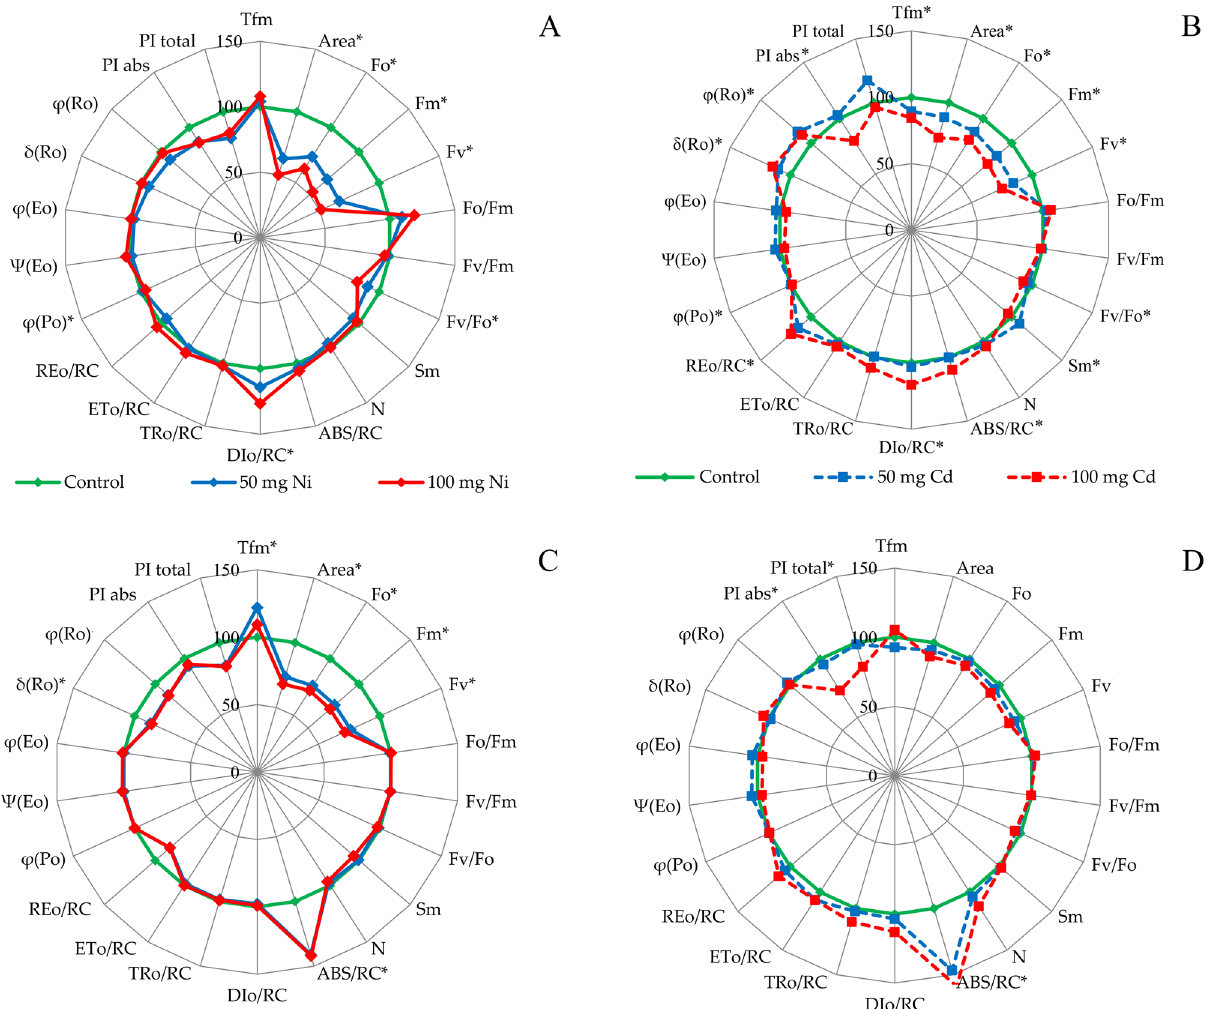
Figure 3. JIP-test parameters (relative units, normalized to the values from control conditions) as radar plots of two perennial ryegrass turf cultivars. ( A ) ‘Niga’ treated by Ni; ( B ) ‘Niga’ treated by Cd; ( C ) ‘Nira’ treated by Ni; ( D ): ‘Nira’ treated by Cd. The concentration of Ni and Cd were: 0; 50 and 100 mg × 100 g −1 of substrate. Means marked by different letters represent statistically significant differences ( p < 0.05, n = 6) delayed chlorophyll a